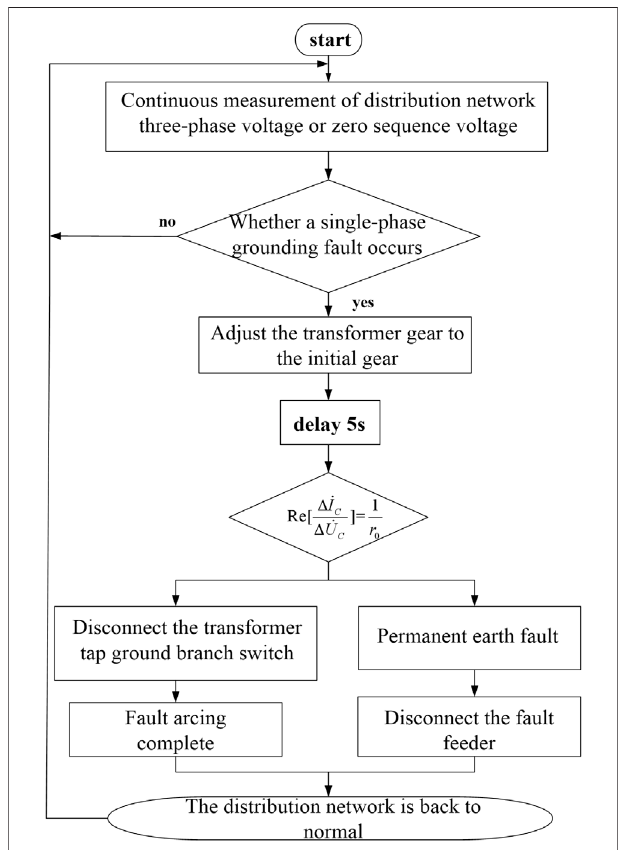
FIGURE 7 | Voltage arc suppression fl ow chart with fl exible voltage control.